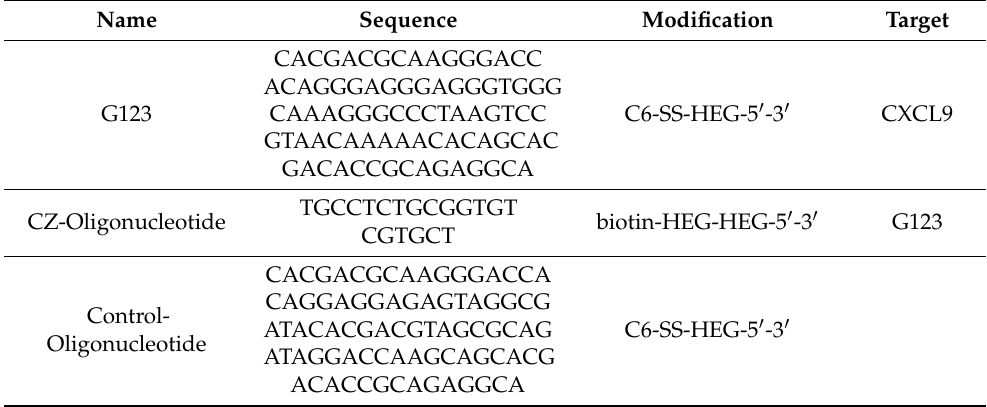
Table 1. Summary of used ssDNAs and their characterization (all obtained from ELLA Biotech, Planegg,